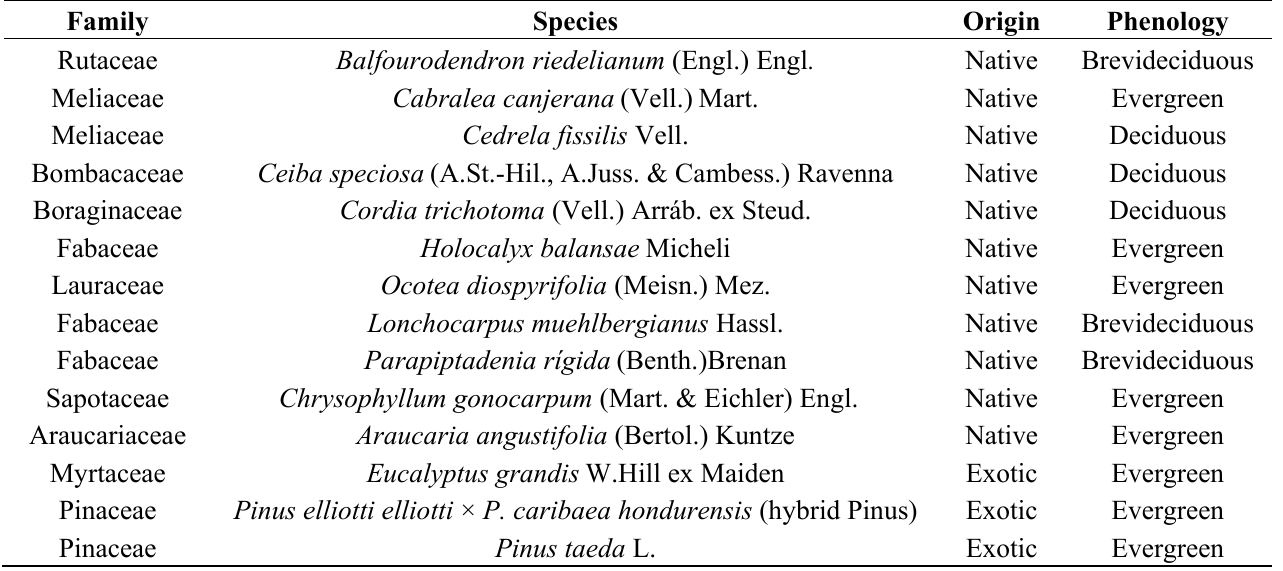
Table 1. List of tree species studied, their family, native or exotic origin, and leaf